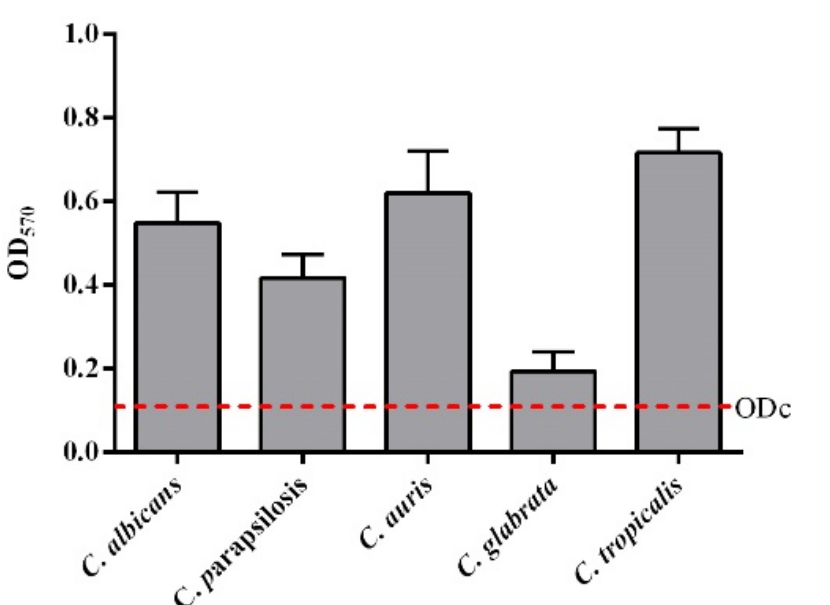
Figure 1. Biofilm formation capacity of five species of microorganisms using the crystal violet staining method. ODcut = mean of negative control with addition of 3 times the SD.